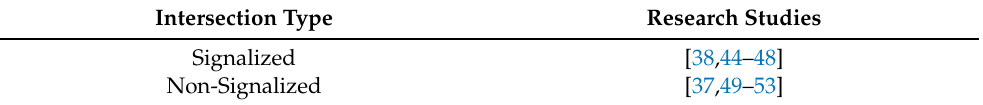
Table 1. Summary of literature review on cooperative intersection